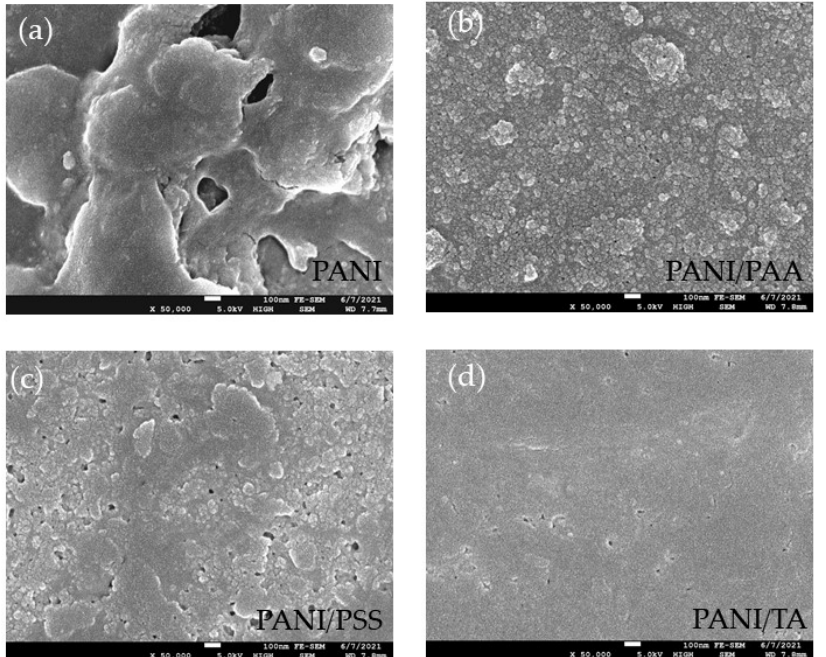
Figure 3. FE–SEM images of: ( a ) PANI, ( b ) PANI/PAA, ( c ) PANI/PSS, and ( d ) PANI/TA films. At a scheme of 100 nm.